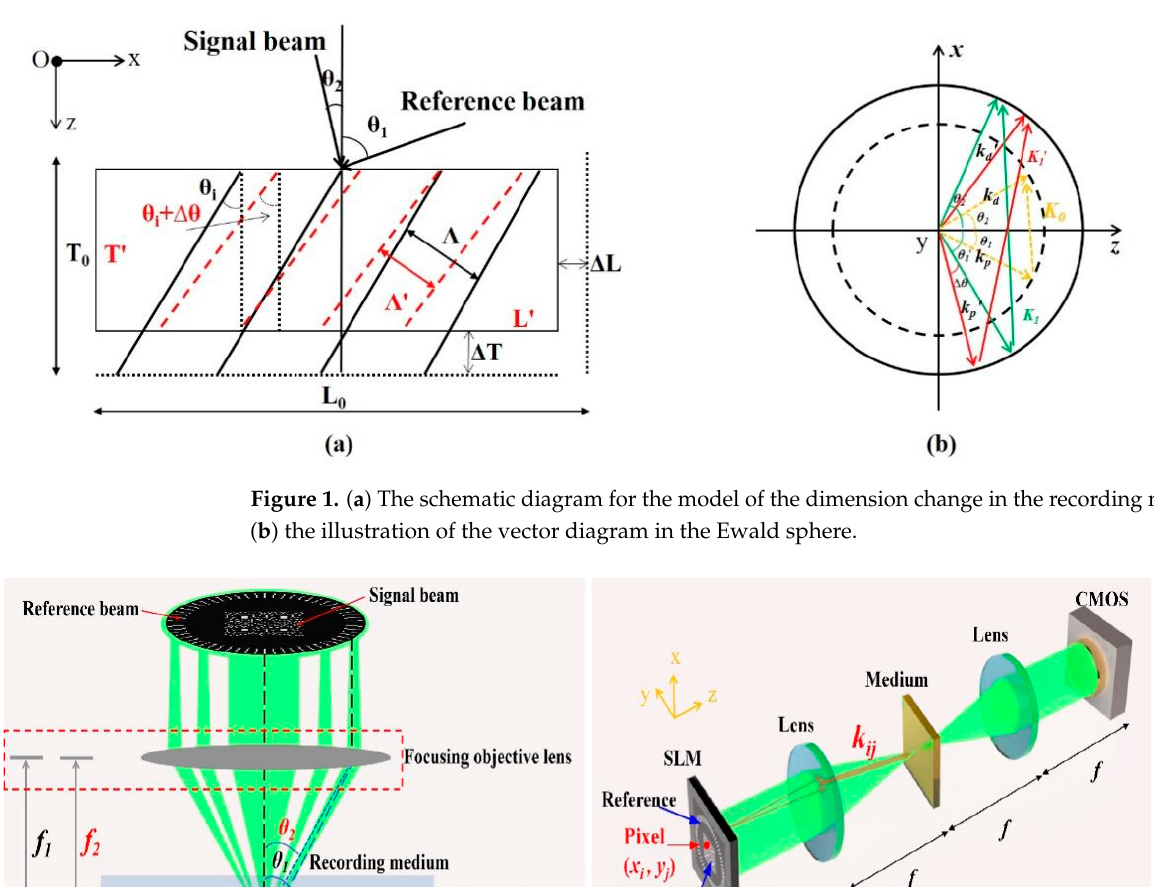
Figure 1. ( a ) The schematic diagram for the model of the dimension change in the recording medium; ( b ) the illustration of the vector diagram in the Ewald sphere.